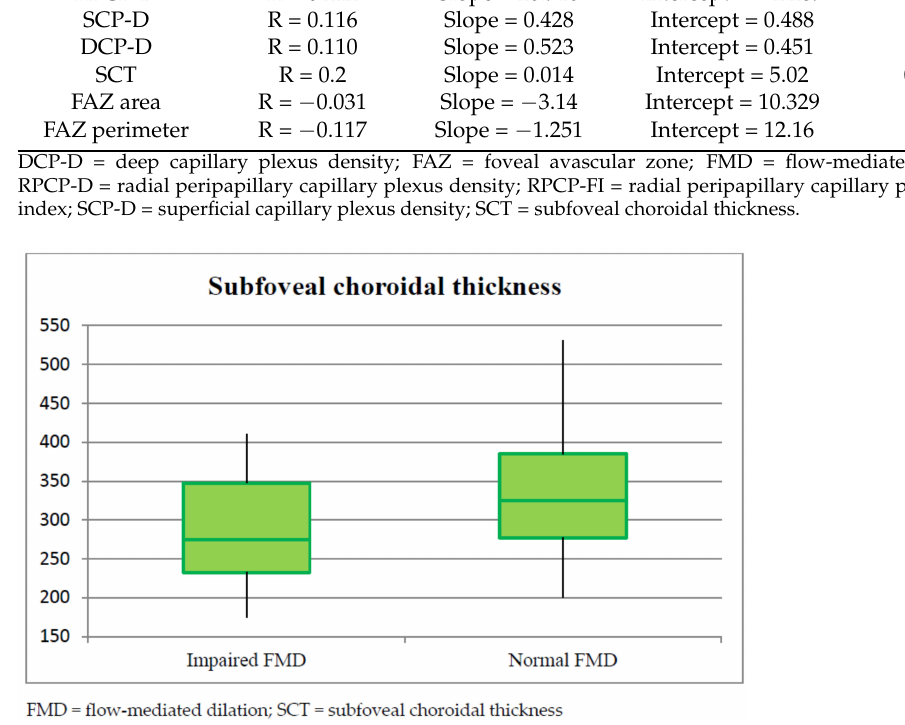
Table 2. Analysis of the linear correlation between retinal vascular OCT and OCTA parameters and flow-mediated dilation (FMD) values in the study population. The p -value in bold is used to underline the linear correlation between RPCP-FI and FMD values in the study population. Variable Linear Correlation To FMD p RPCP-FI R = 0.244 Slope = 81.455 Intercept = − 27.467